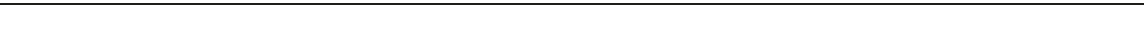
Fig. 4 Electrochemical properties of few-layered SBS and SBS/C electrodes. Comparison of ( a ) cycling performance and ( b ) rate performance of SBS/C (NS-1-E), SBS/C (NS-2-E), and SBS/C (NS-3-E) electrodes, which were exfoliated and collected in ethanol. Comparison of ( c ) cycling performance and ( d ) rate performance of layered SBS (NS-1-W), SBS (NS-2-W), and SBS (NS-3-W) electrodes, which were exfoliated and collected in water. e Discharge/ charge curves at different cycles of SBS/C (NS-2-E) composite at 50 mA g − 1 . Ex situ X-ray photoelectron spectroscopy (XPS) of the S 2p peaks of ( f ) SBS/ C (NS-2-E) and ( g ) bulk SBS electrodes after the 50 th charge. h Rate capabilities of SBS/C electrodes exfoliated with different solvents (E/W = 1:1, E/W